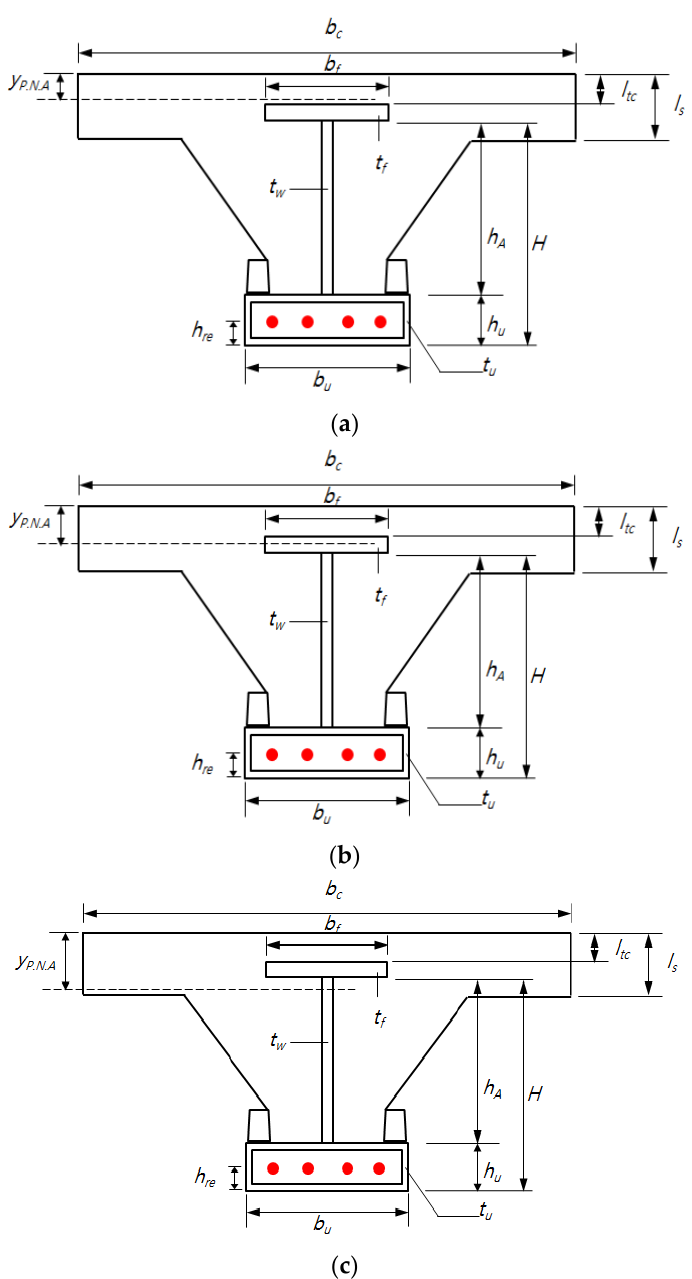
Figure 11. Locations of plastic neutral axis for the fully composite specimen: ( a ) above the upper flange; ( b ) at the upper flange; ( c ) below the upper flange.